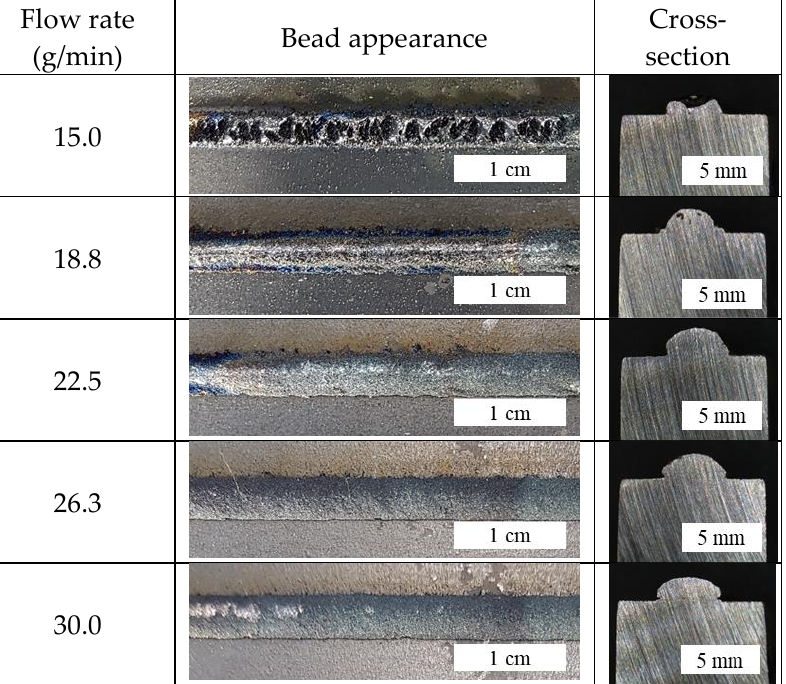
Figure 8. Bead height, width, and aspect ratio with various flow rates of Fe powder.